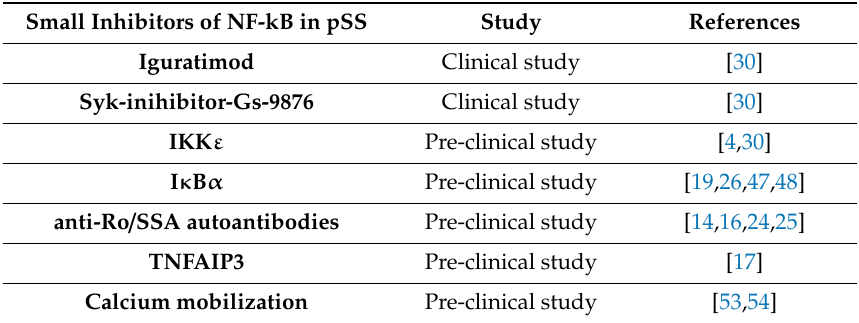
Table 1. List of NF- κ B small molecules inhibitors tested or identified in primary SS (pSS). Small Inhibitors of NF-kB in